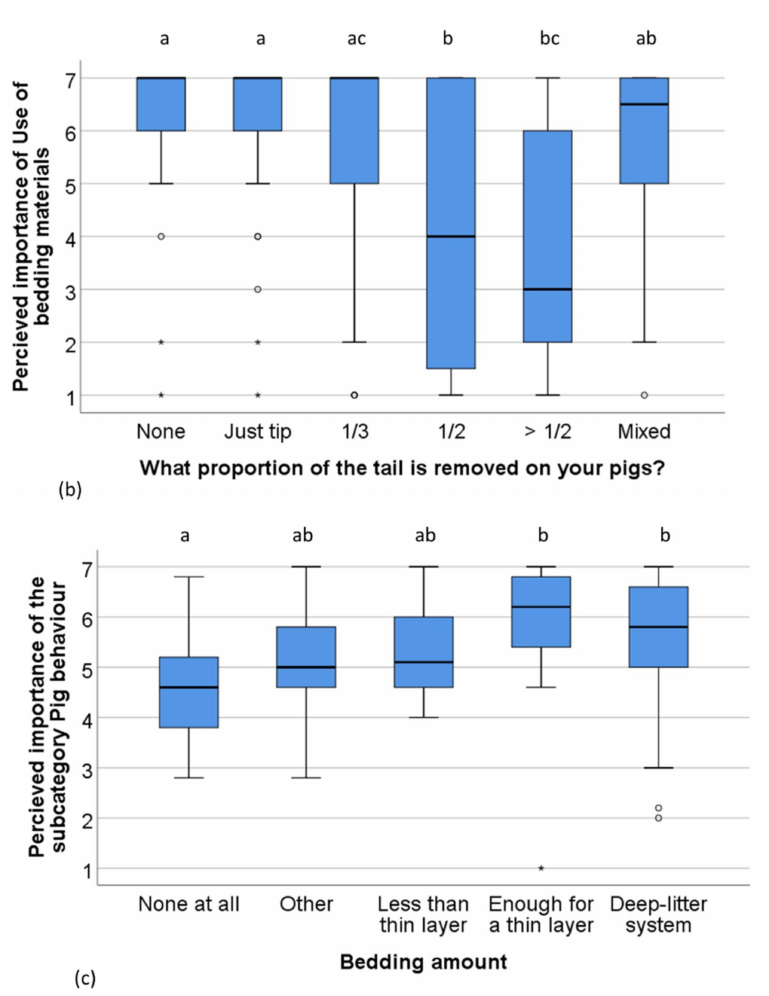
Figure 1. Distribution of overall mean rating of factors within the Pig behaviour subcategory ( a ) and the rating of the measure Use of bedding ( b ) of respondents ( n = 176) which rear pigs with di ff erent proportions of the tails removed. ( c ) shows the distribution of overall mean rating of factors within the Pig behaviour subcategory of respondents using di ff erent amounts of bedding on their farms ( n = 181). Scale: 1 (not important) to 7 (extremely important). The boxplot indicates medians and quartiles (25% and 50%) as well as outliers. Boxes lacking common letters di ff er ( p <